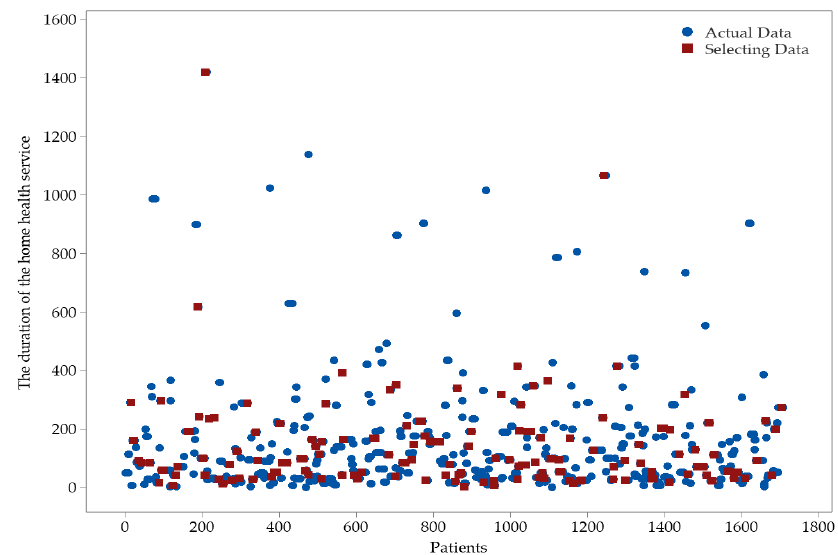
Figure 5. The data selected for the testing phase in the dataset.